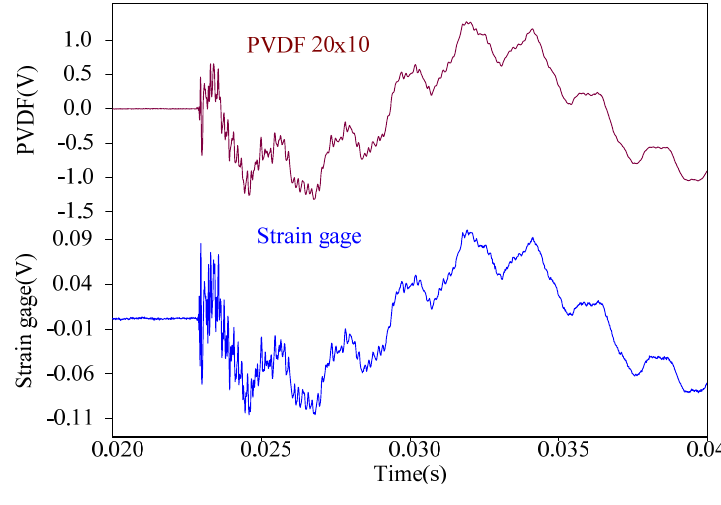
Figure 11. Measurement results of PVDF 20 × 10 and the strain guage with impact on location